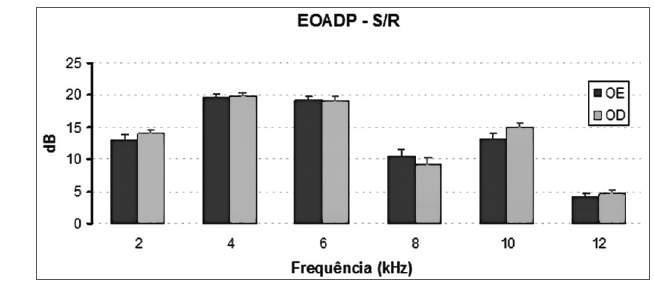
Figura 5. Média e desvio padrão das amplitudes das EOAPD registra- das para cada gênero em cada frequência. F: Feminino, M: Masculino. Teste ANOVA, p < 0,007.